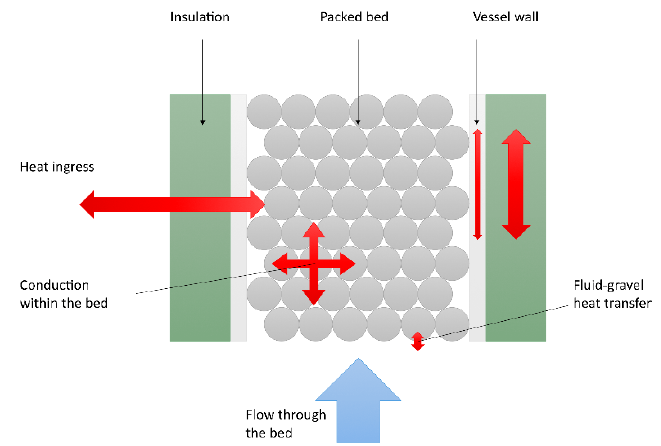
Figure 3. Cross-section through a packed bed regenerator showing conduction and flow paths.